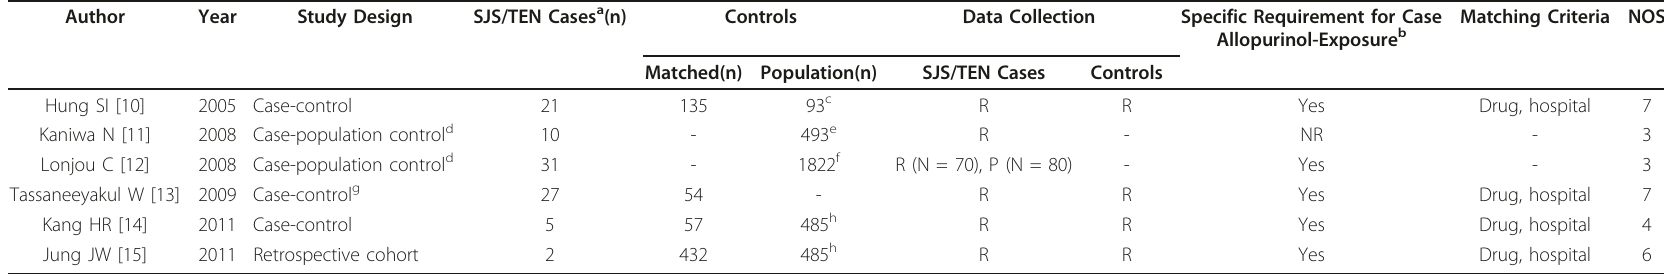
Table 1 Characteristics of studies included in the